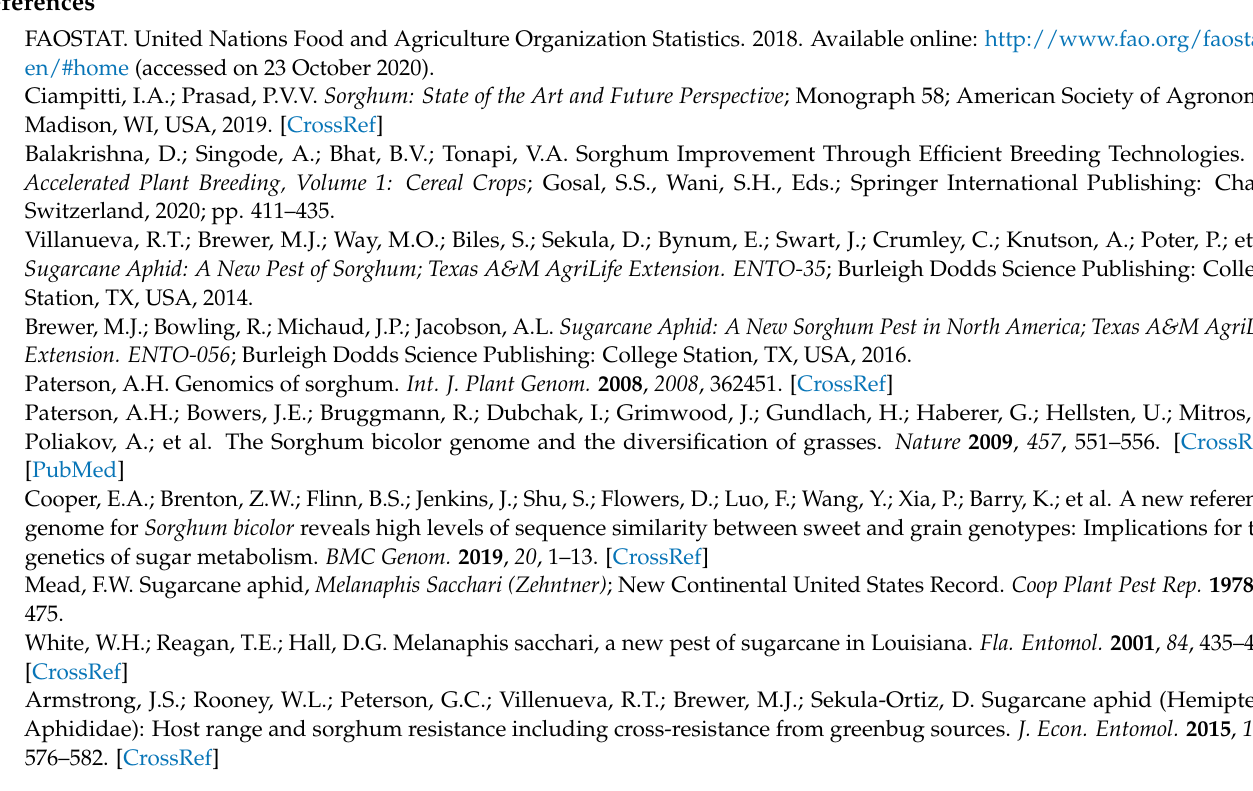
Table S1: Sequence quality of RNA-Seq reads as checked by trimmomatic at minimum length 36 and % mapped to the reference sorghum genome; Table S2: Gene ontology annotation of differentially expressed genes in the R genotype in the course of SCA